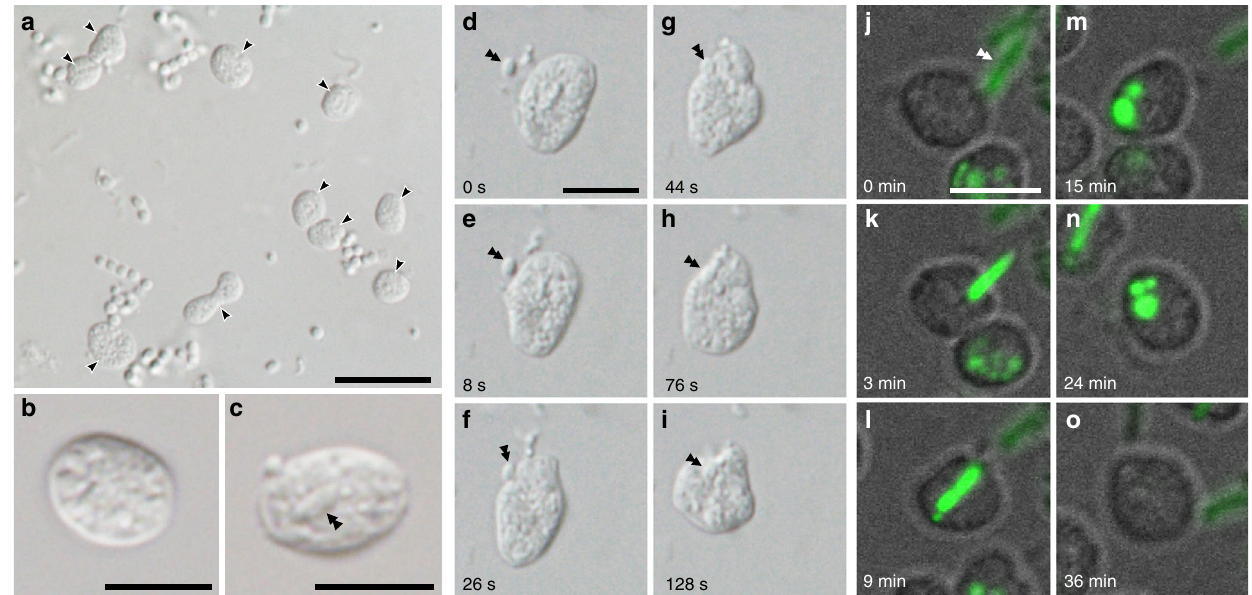
Fig. 1 Light and fl uorescent micrographs of ‘ Candidatus Uab amorphum ’ . a Cells of ‘ Ca . Uab amorphum ’ (arrowheads) in the xenic culture. b , c A cell of ‘ Ca . Uab amorphum ’ . Double arrowheads indicate an engulfed bacterium. d – i Selected images of time-lapse video showing prey engulfment process of ‘ Ca . Uab amorphum ’ . j – o Selected images of confocal fl uorescent time-lapse video showing prey engulfment and digestion process of ‘ Ca . Uab amorphum ’ . Green fl uorescence indicates AcGFP1-labelled Escherichia coli . Scale bars, 10 μ m ( a ) and 5 μ m ( b – o